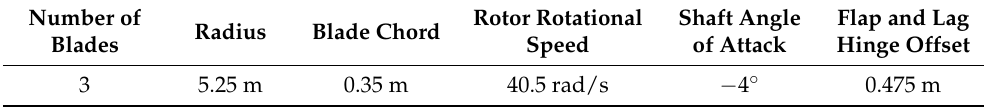
Table 1. Parameters of the main